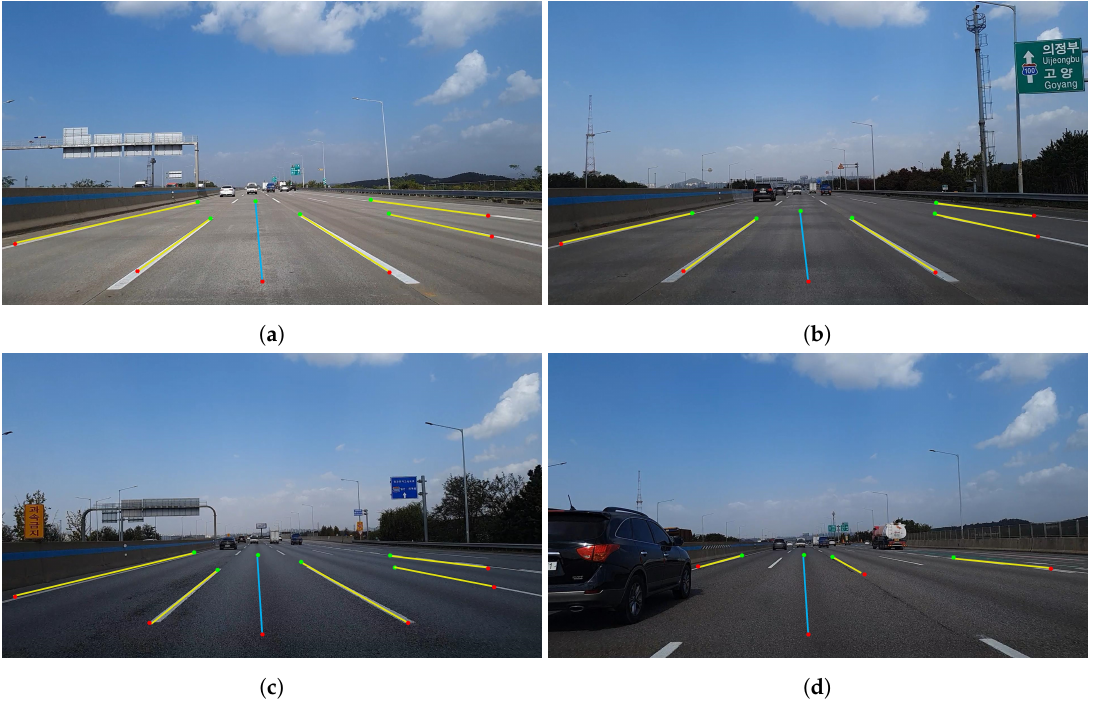
Figure 10. Results of driving link extraction in course 1: (a,b,c) correct detection of vehicle lines and extraction of driving link; (d) incorrect detection of vehicle lines but update previous driving